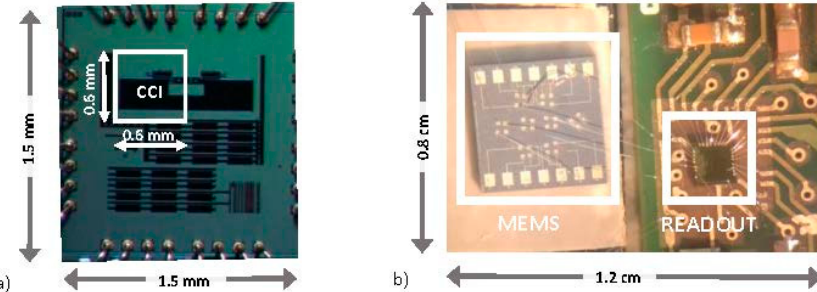
Figure 3. ( a ) Microphotograph of the ASIC embedding the CCI-based sustaining amplifier ( b ) Photo of the ASIC directly bonded to the DETF.